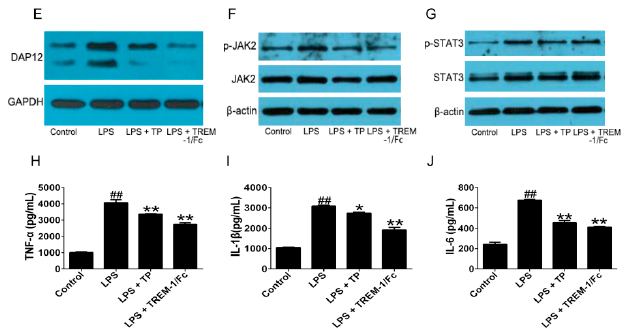
Figure 3. Effects of TP on TREM-1 signal pathway and inflammatory cytokines expression in LPS-induced U937 cells. ( A ) Effect of TP on TREM-1 mRNA levels in U937 cells, as measured with quantitative RT-PCR; ( B ) Effect of TP on the secretion of TREM-1, as measured with enzyme-linked immunosorbent assay (ELISA); ( C ) Effect of TP on TREM-1 protein levels in U937 cells, as measured with western blot; ( D ) Effect of TP on the expression of TREM-1 on U937 cells surface, as measured with flow cytometry; ( E – G ) Effect of TP on DAP12, p-JAK2, p-STAT3 protein levels in U937 cells, as measured with western blot; and ( H – J ) Effect of TP on the secretion of TNF- α , IL-1 β , IL-6, as measured with ELISA. Data are expressed as mean ± SD from three independent experiments. ## p < 0.01, compared to the control group. ** p < 0.01, * p < 0.05, compared to LPS group. FL2-A means the fluorescence peak area in flow cytometric analysis.